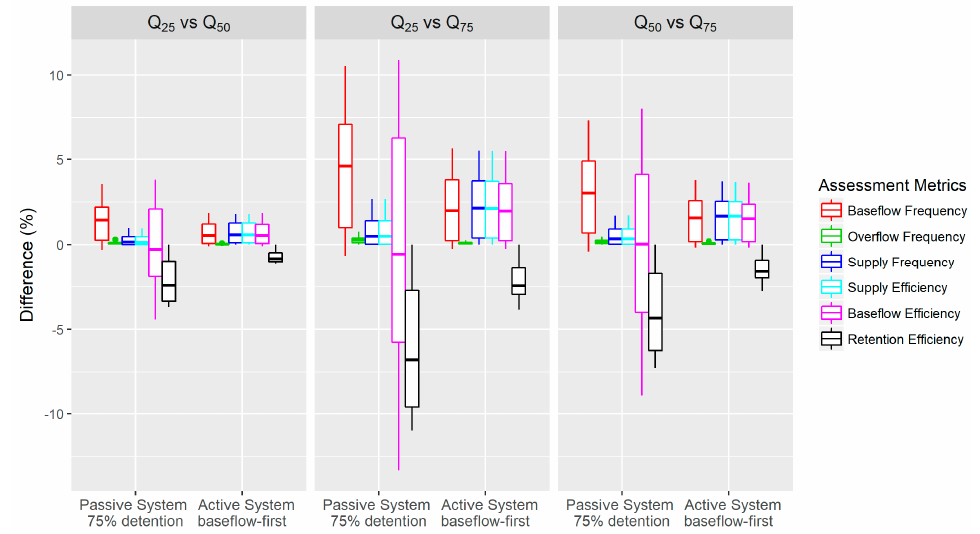
Figure 6. Distribution of difference in performance between baseflow targets among all possible scenarios in Passive Release System (75% Detention Volume) and Baseflow-First Active Release System (RTC-B) respectively.